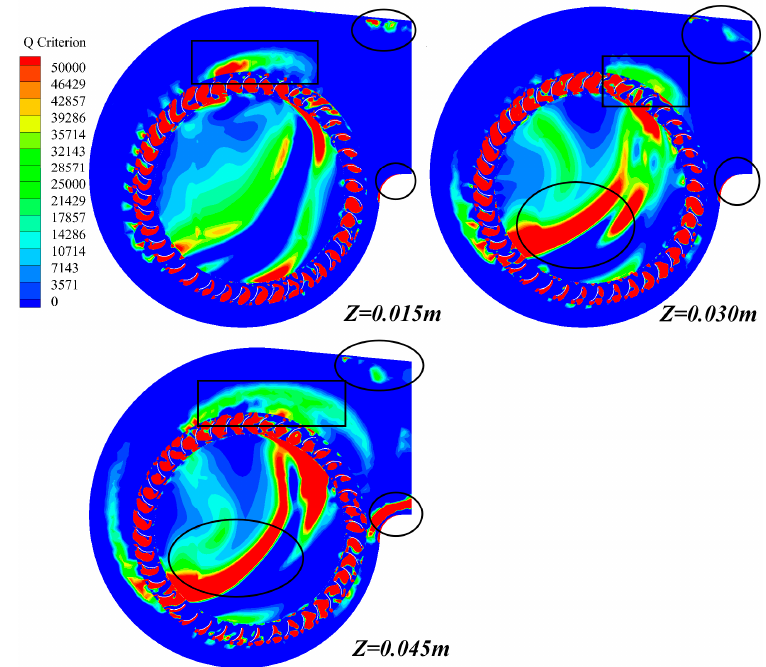
Figure 10. Q value distribution of cross-sections at different positions (Q/Qn = 0.031).